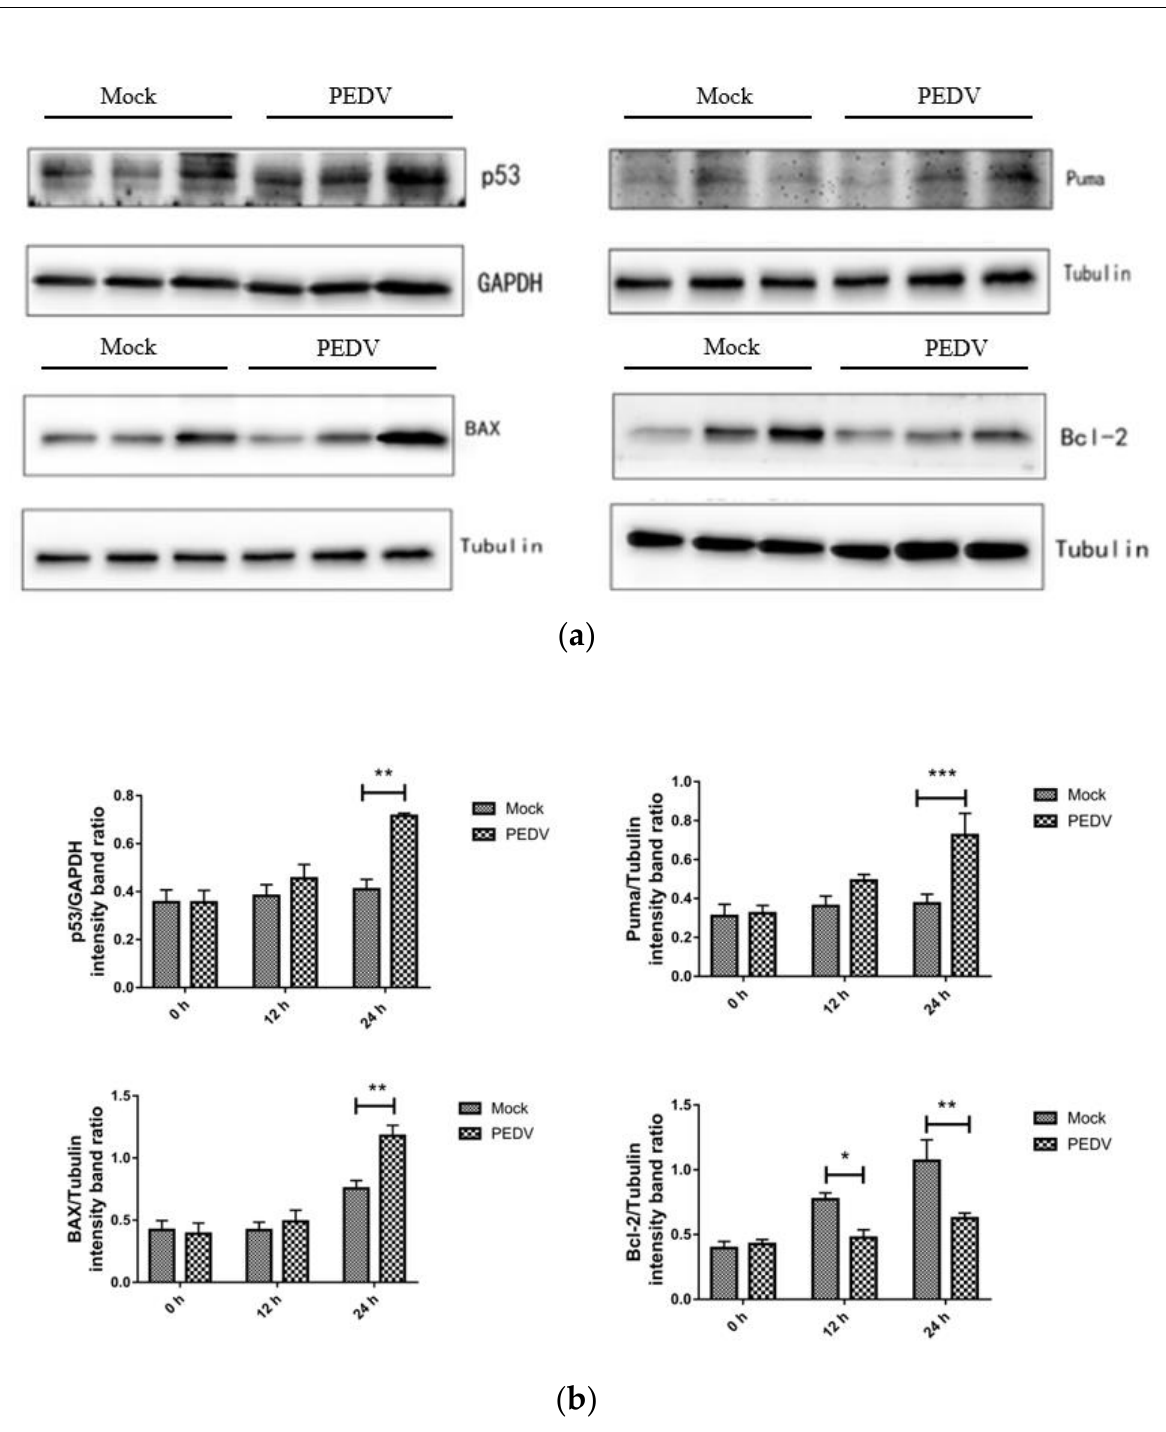
Figure 6. Effect of PEDV infection on p53 signaling pathway-related protein expression by Western blotting ( a ) and the intensity band ratio of Western blotting ( b ). *, p < 0.05; **, p < 0.01; ***, p < 0.001. 3.9. The Effect of Inhibitor PFT- α on Proteins of p53, Puma, BAX and Bcl-2 Western blotting was used to detect the changes of proteins p53, Puma, BAX, and Bcl-2 under PFT- α (10 mM) treatment for 24 h. As shown in Figure 7, PEDV